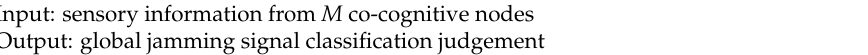
Table 4. Multi-node cooperative jamming recognition method based on soft decision.